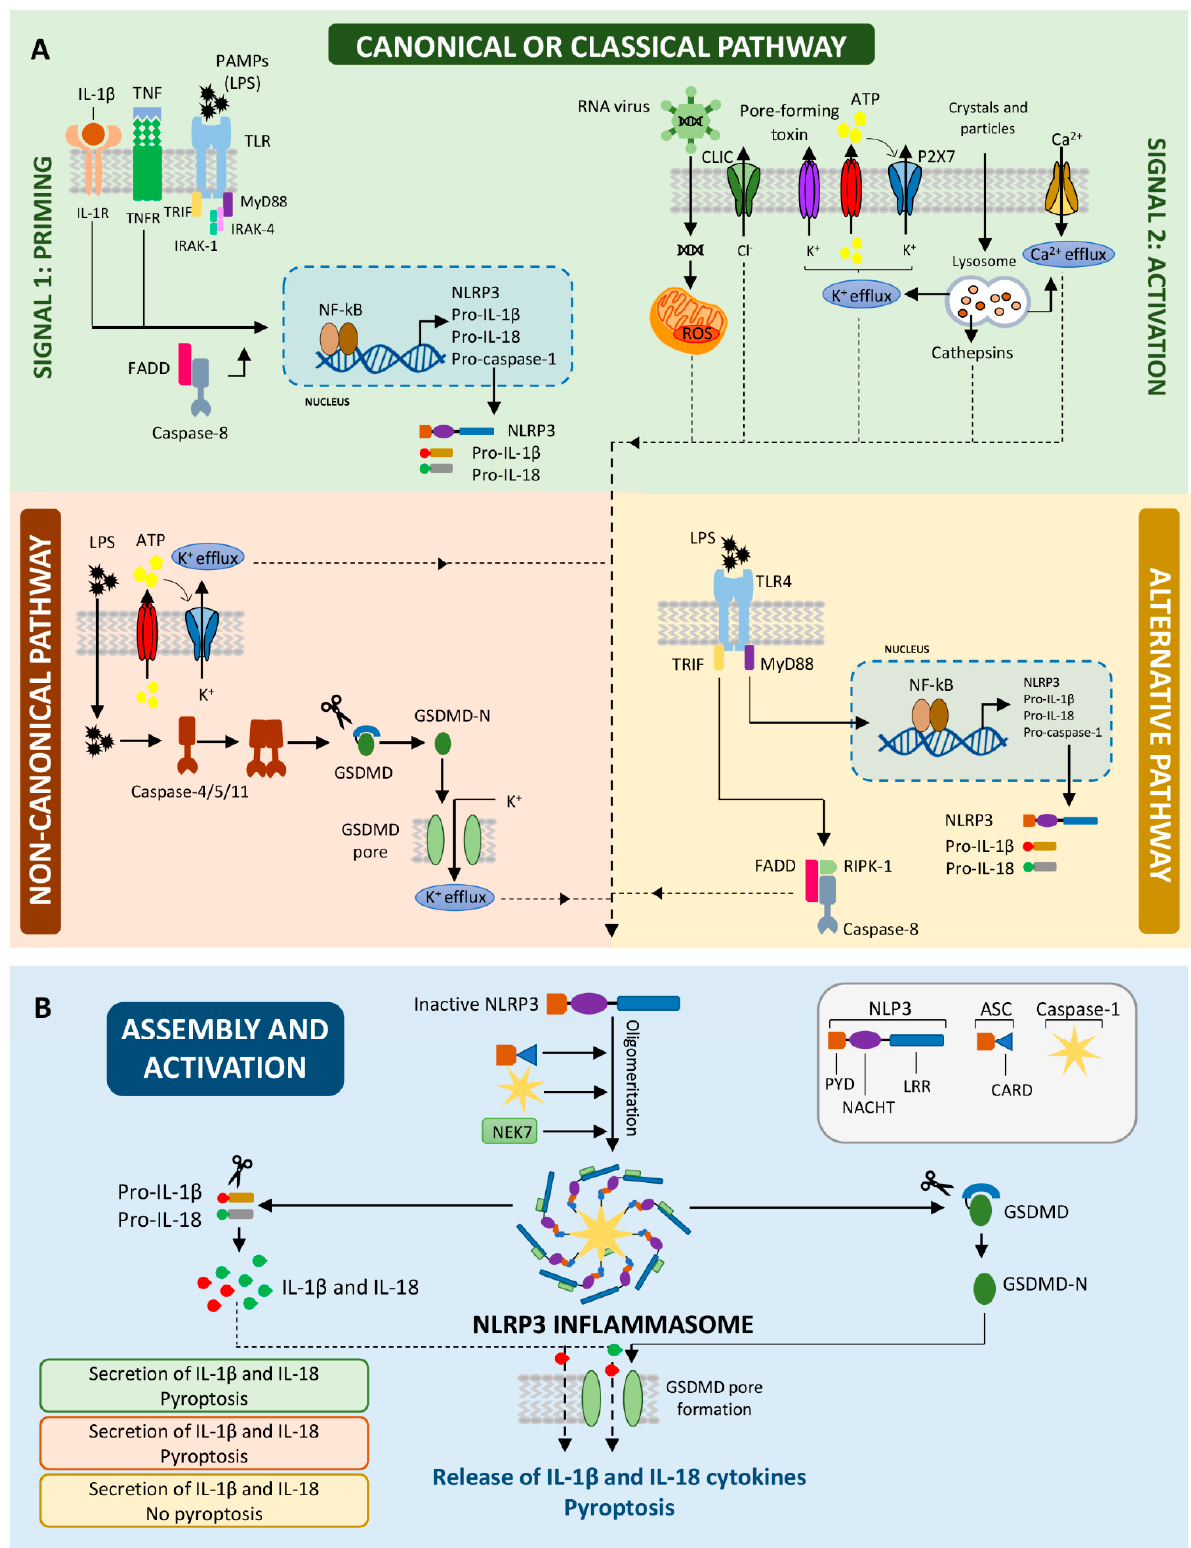
Figure 1. Pathways involved in NLRP3 inflammasome priming and activation. ( A ). Activation of the NLRP3 inflammasome requires an initial priming step aimed to upregulate the expression of inflammasome components. That first signal, or priming (left panel), is provided by PAMPs that induce NF- k B activation, thereby triggering the transcription of